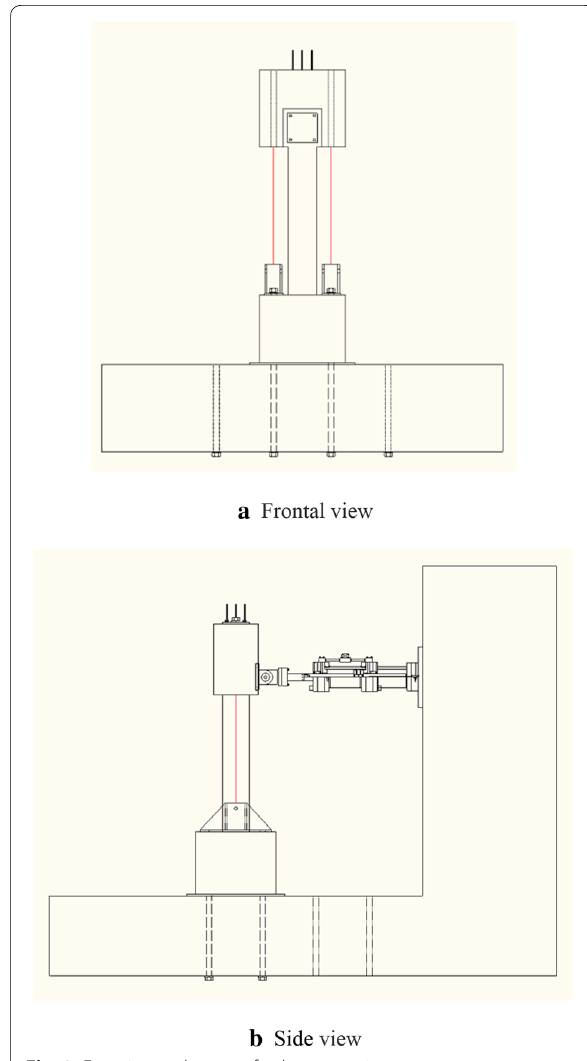
Fig. 8 Experimental setup of column